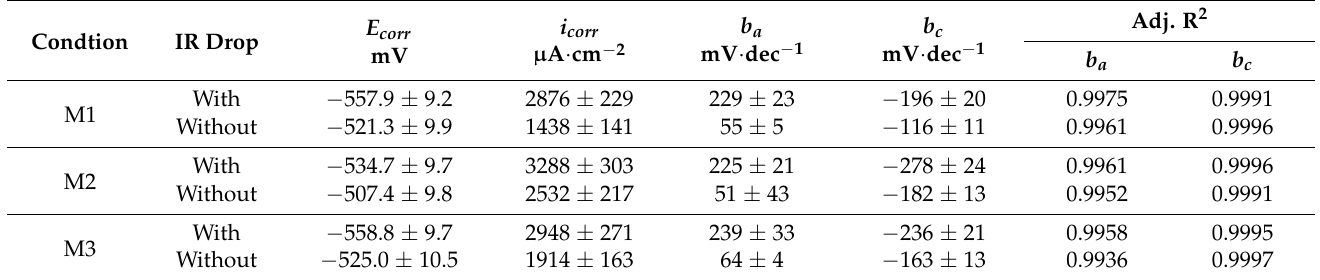
Table 4. Fitting results of polarization curves with and without an IR drop by Tafel extrapolation under three measurements in H 2 SO 4 solutions after exposure for 2 h.